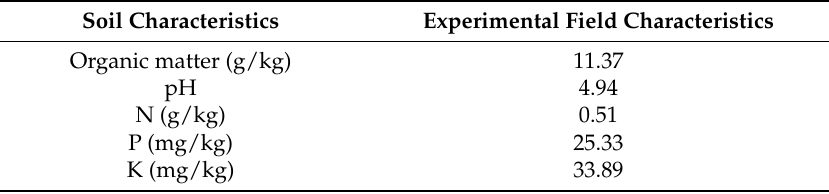
Figure 3. Different plant organs of B. balsamifera ( A )-young leaves, ( B )-mature leaves, ( C )-senescent leaves, ( D )-dead leaves, ( E )-young shoots, ( F )-young stems. Table 5. Soil characteristics of the experimental site used in the present